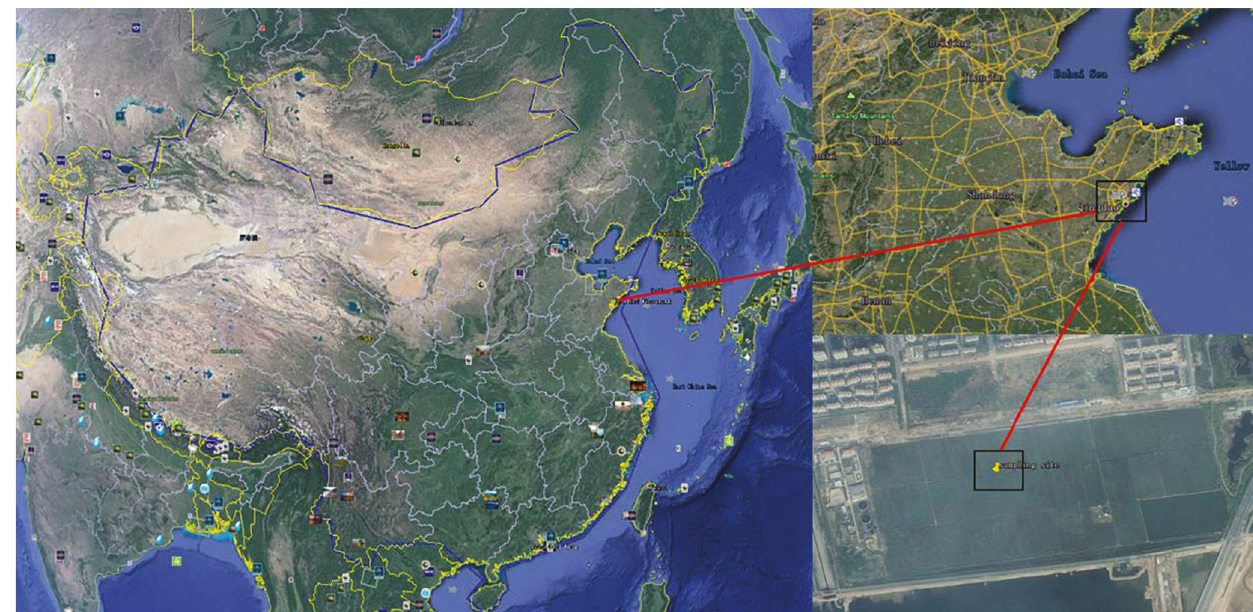
Figure 1: Map showing the location of the sampling sites in constructed